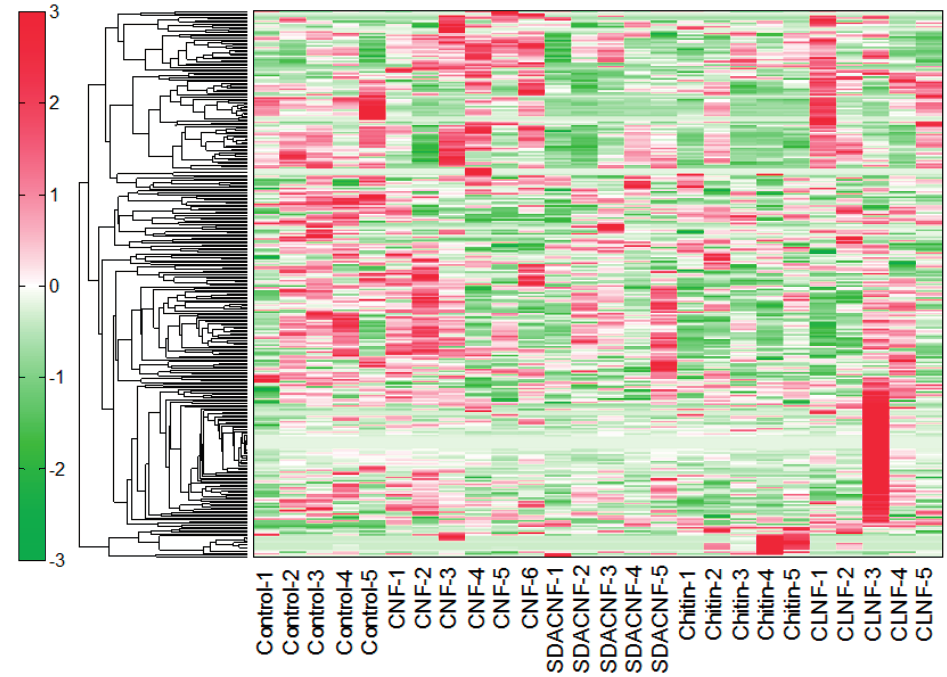
Figure 1. Results of hierarchical cluster analysis of plasma metabolites. An ordinate and an abscissa indicate peaks and names of experimental groups, respectively. Hierarchical cluster analysis (HCA) was performed for peaks, and distance between peaks are shown as tree diagrams. Denser green and red indicate shorter and longer distances than those of the control group, respectively. CNF, chitin nanofiber; SDACNF, surface-deacetylated CNF; CLNF, cellulose